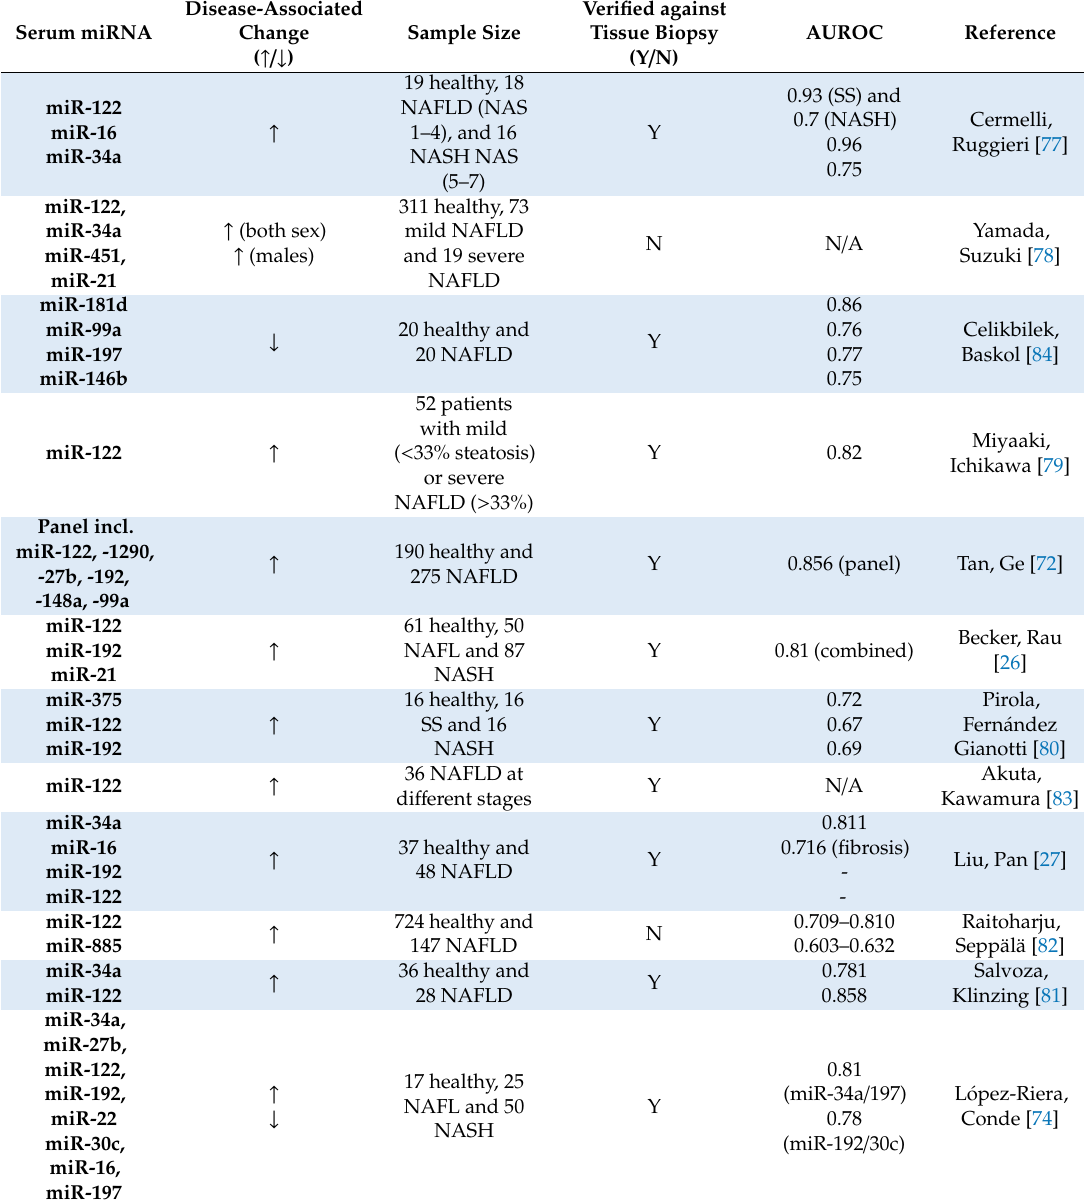
Table 1. Summary of serum miRNA biomarker studies in patients with non-alcoholic fatty liver disease